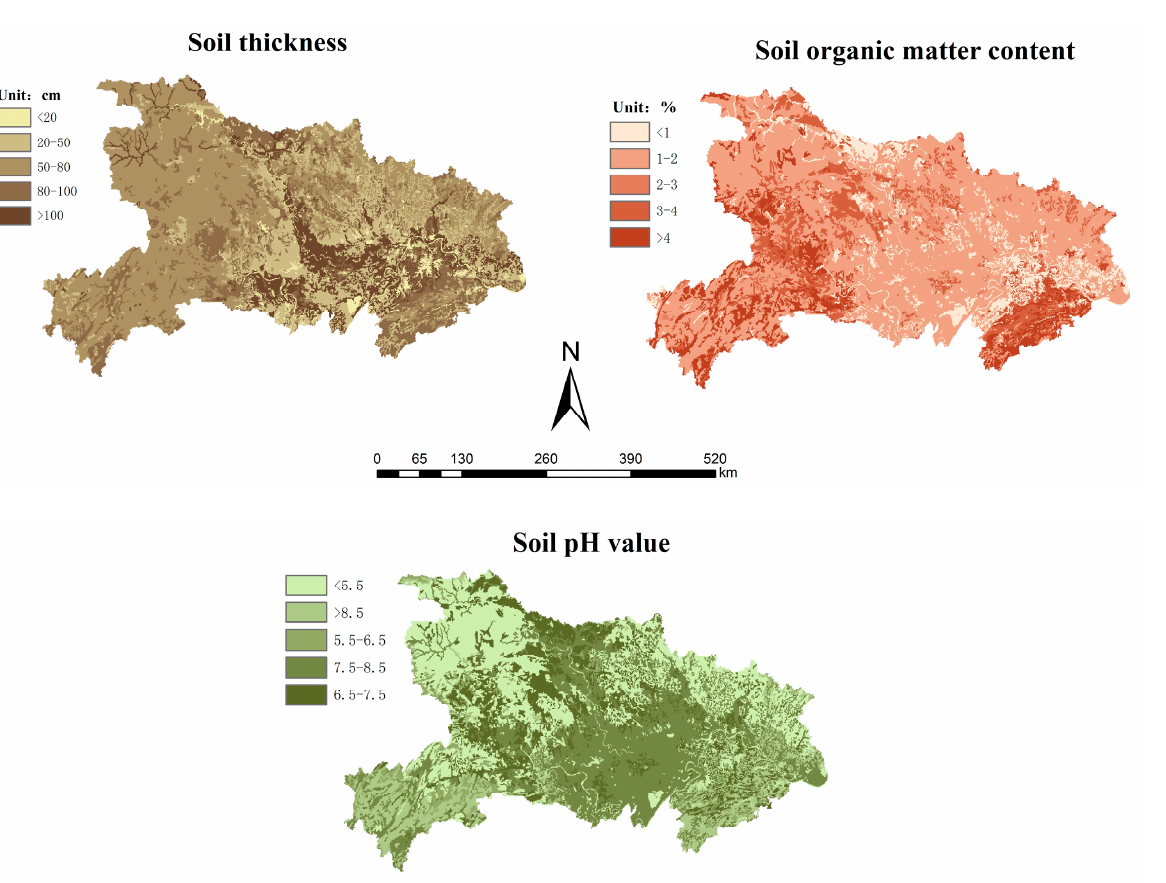
Figure 3. Soil Figure 3. Soil conditions.